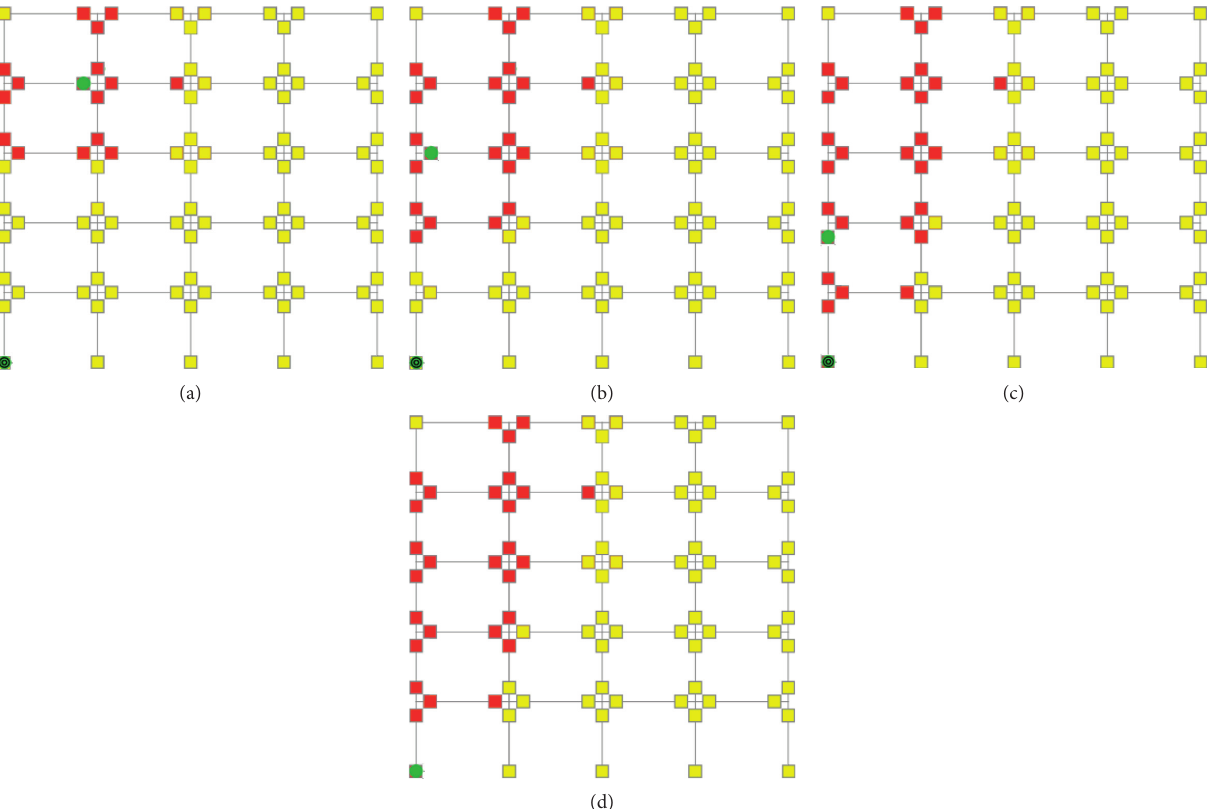
Figure 13: An example of the identification procedure for a frame with five floors and five columns. Starting from its initial position on a randomly selected section (a), the jumper (green circle) progressively explores its neighbouring sections (coloured in red) and moves on those with the best fitness (b-c) until it reaches the target at the end of the run. See text for more